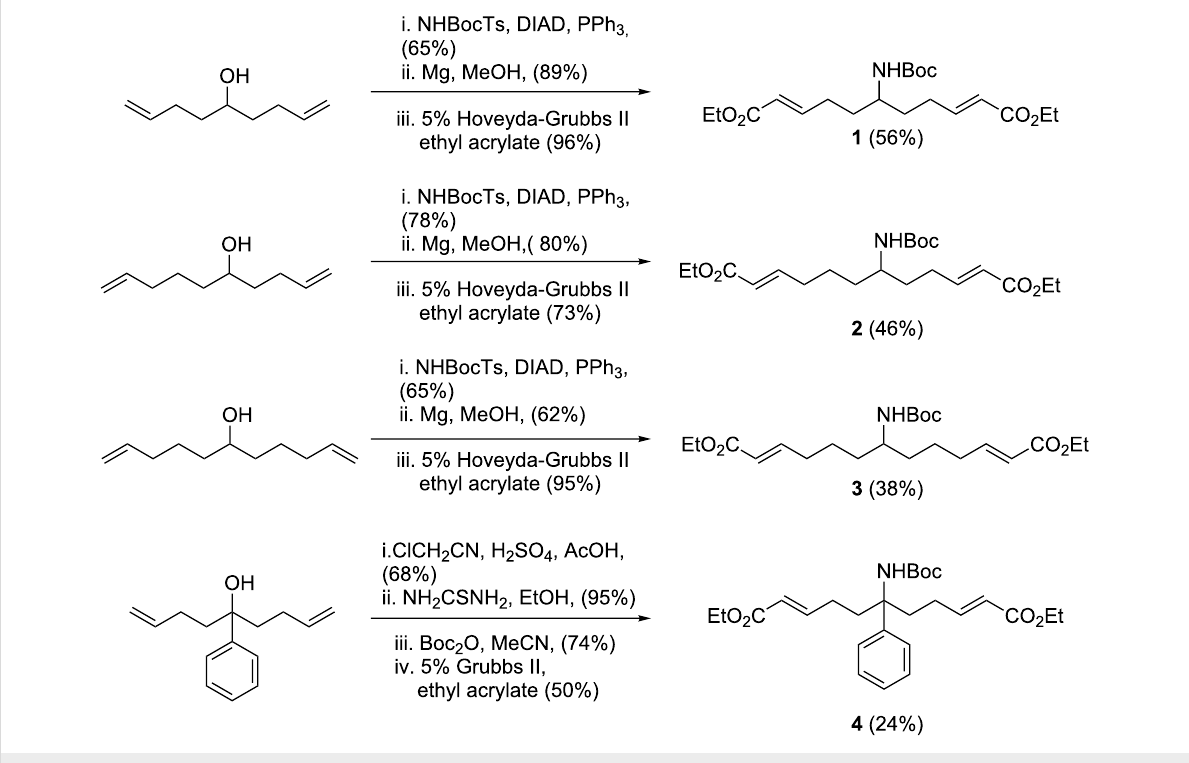
Scheme 1: Synthesis of linear cyclisation precursors 1 – 4